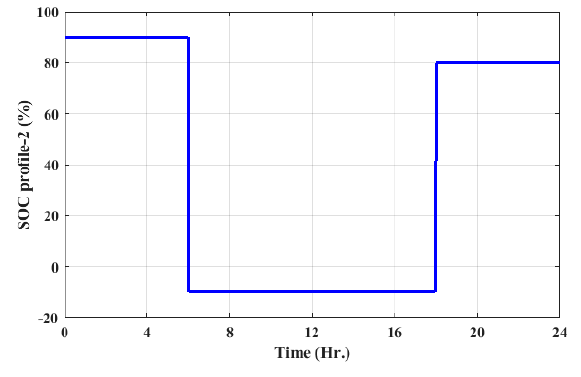
Figure 9. Figure 7. Load profile.